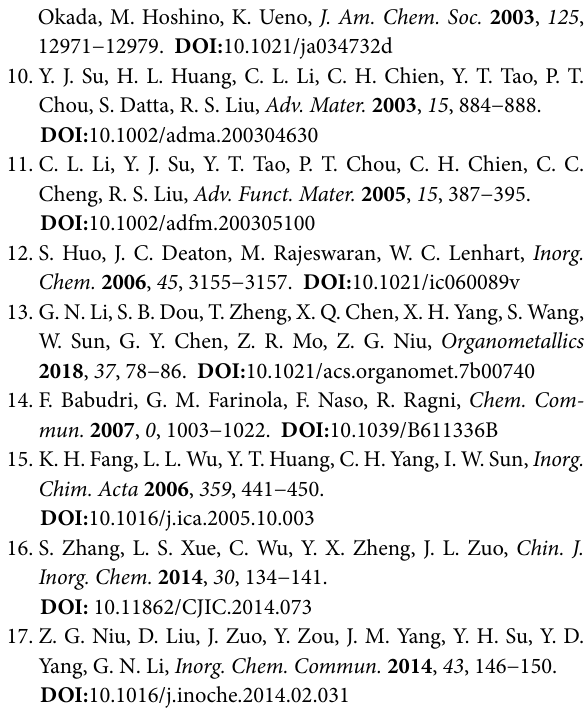
quasi-reversible/irreversible oxidation peak ( E ox ) at